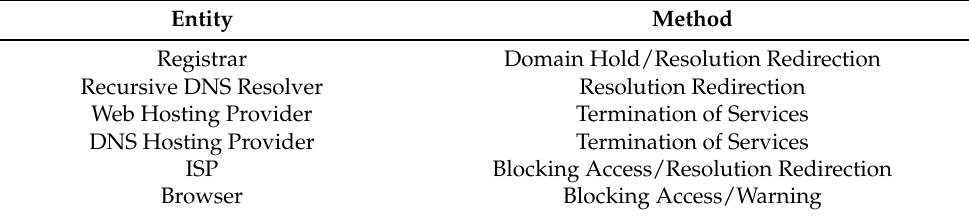
Table 1. Summary of methods for Internet entities to deal with abusive domain